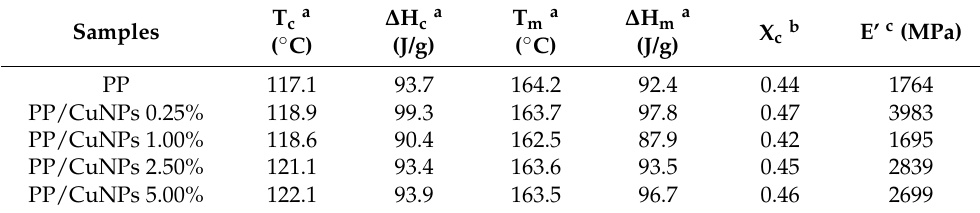
Table 1. DSC and DMA data corresponding to iPP/CuNPs